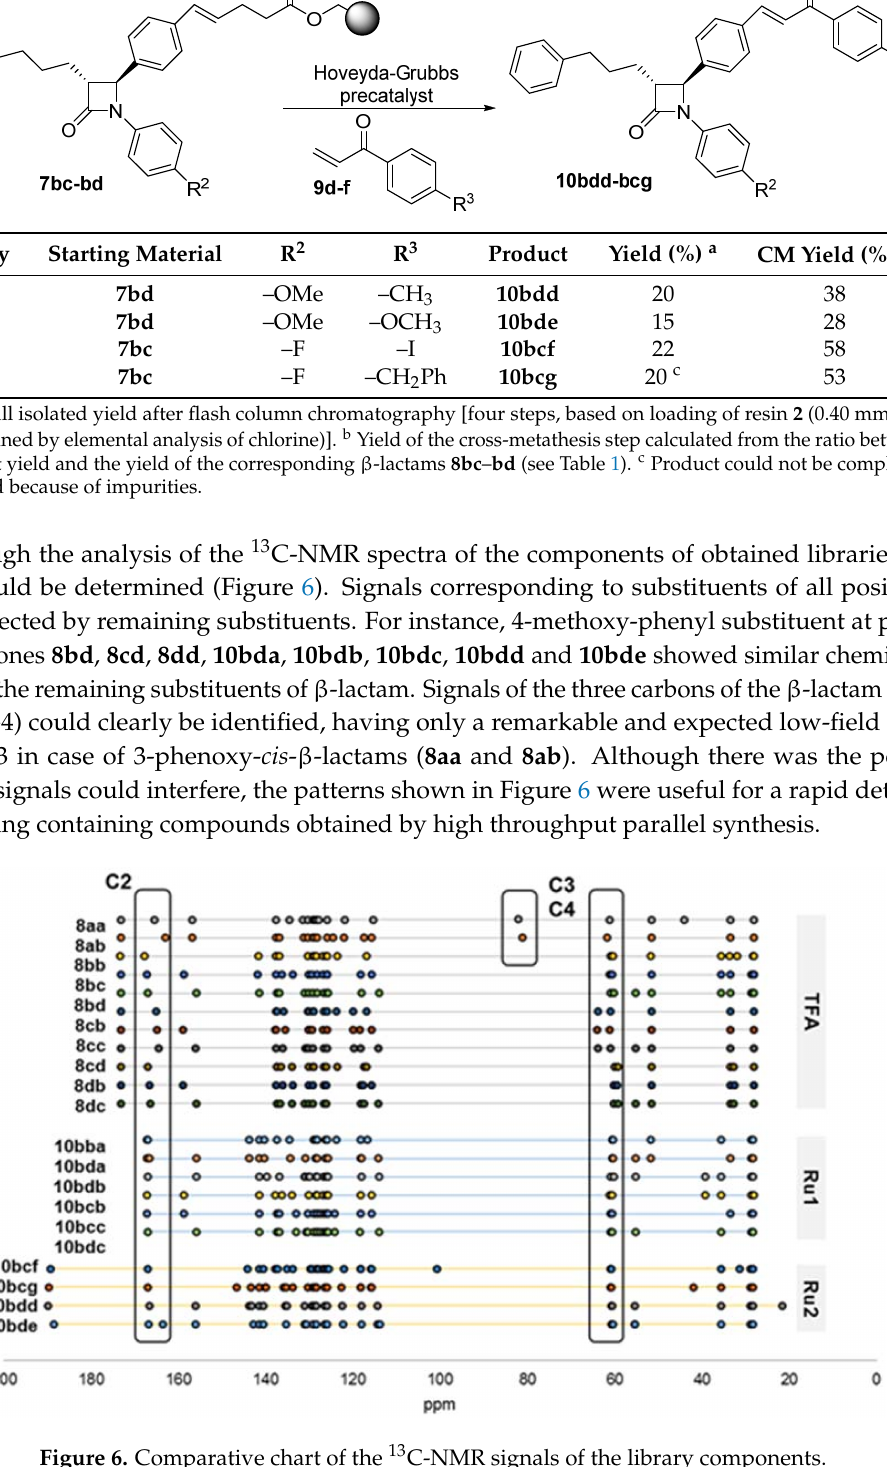
Figure 6. Comparative chart of the 13 C-NMR signals of the library components.